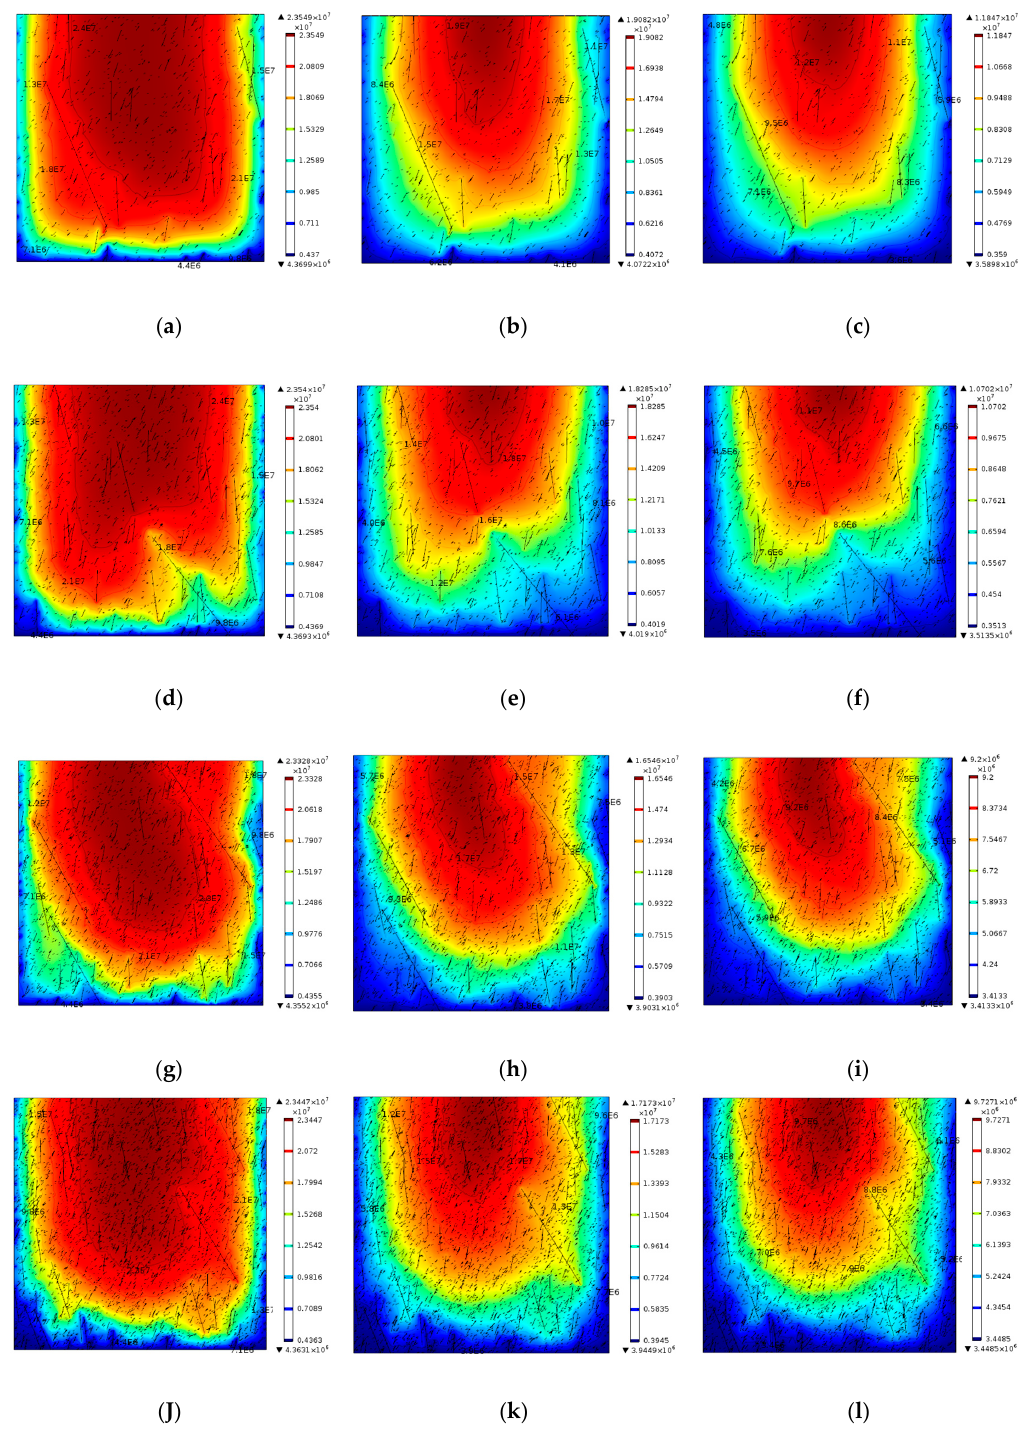
Figure 7. Reservoir pressure variation with time at different fractal dimensions of fracture length: ( a ) one month and D l = 1.5; ( b ) one year and D l = 1.5; ( c ) three years and D l = 1.5; ( d ) one month and D l = 1.6; ( e ) one year and D l = 1.6; ( f ) three years and D l = 1.6; ( g ) one month and D l = 1.7; ( h ) one year and D l = 1.7; ( i ) three years and D l = 1.7; ( j ) one month and D l = 1.8; ( k ) one year and D l = 1.8; ( l ) three years and D l =